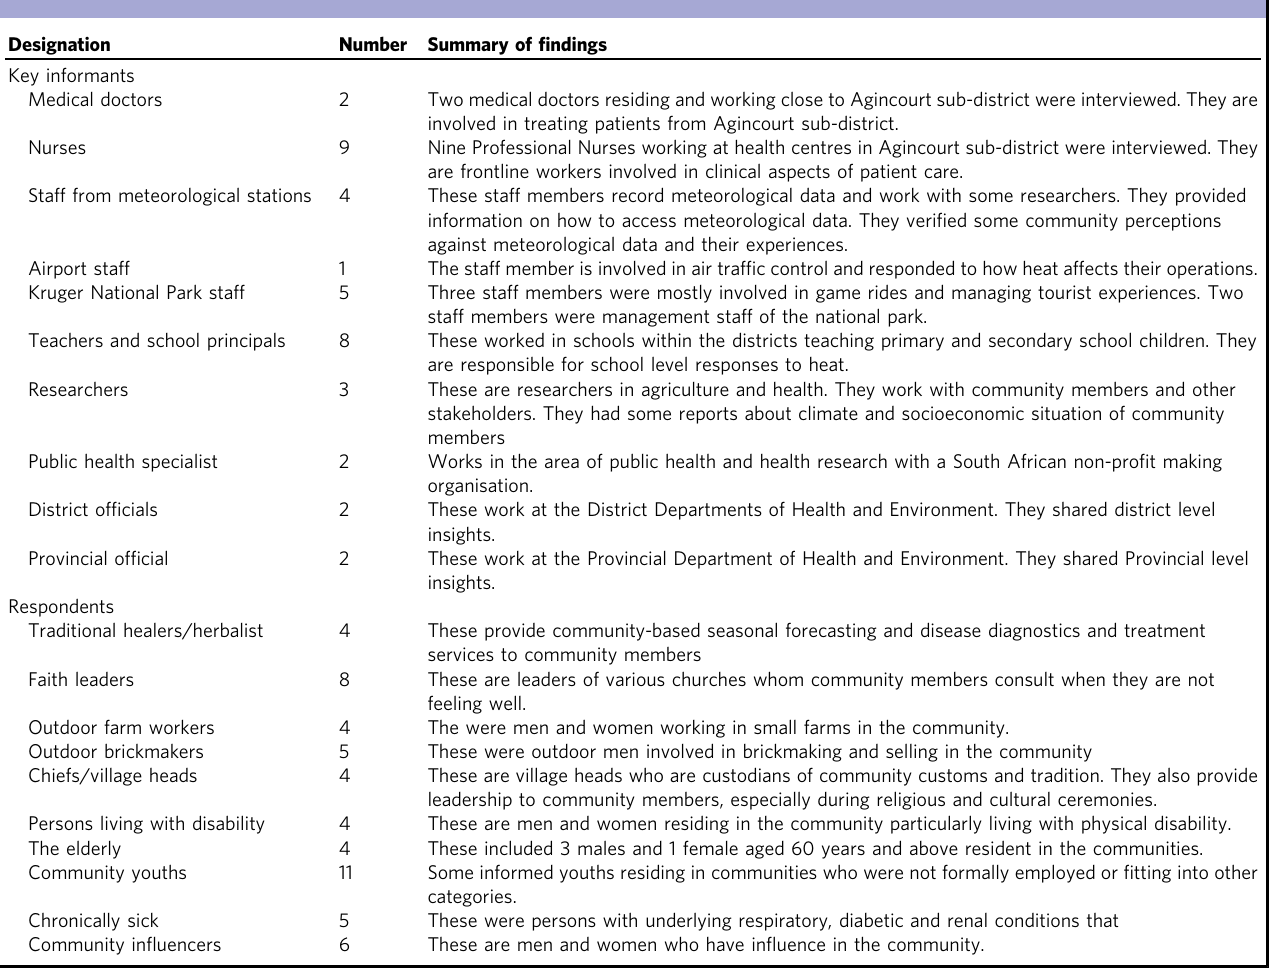
Table 4 Summary characteristics of key informants and